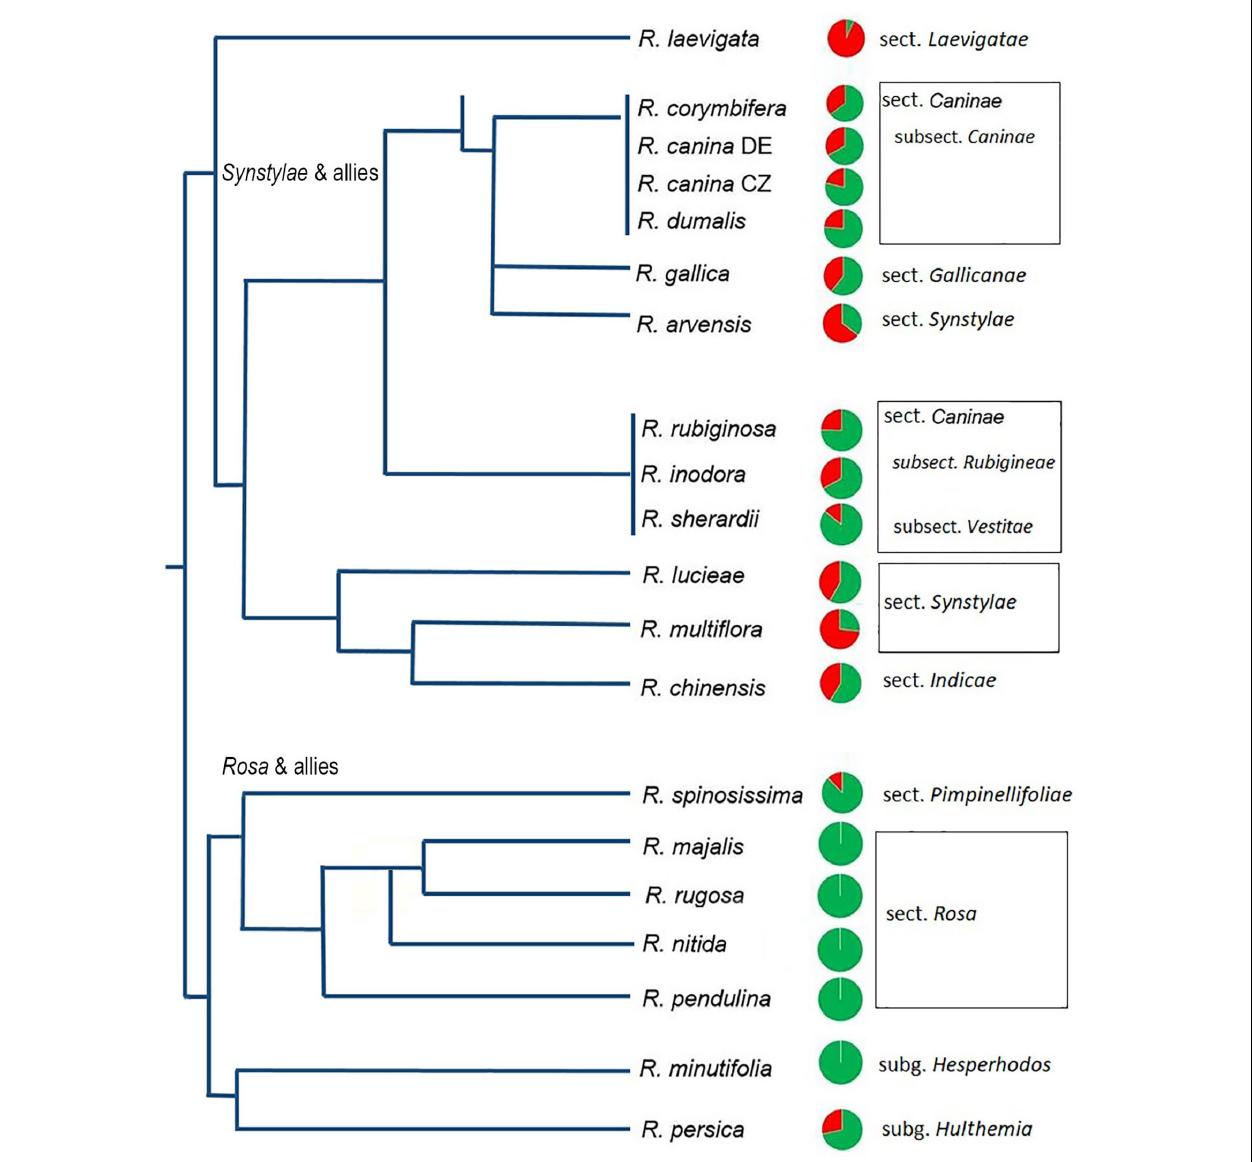
FIGURE 2 | Quantitative relationships between 5S_A and 5S_B rDNA families in Rosa genomes. Genomic proportions of families calculated from high-throughput reads are shown as pie charts next to the species names. Green—5S_A family, red—5S_B family. Data are in Supplementary Table S3 ; data for R. nitida are taken from FISH ( Supplementary Figure S5 ). A simplified phylogenetic tree is redrawn according to published phylogenies based on plastid sequences (Fougere-Danezan et al.,